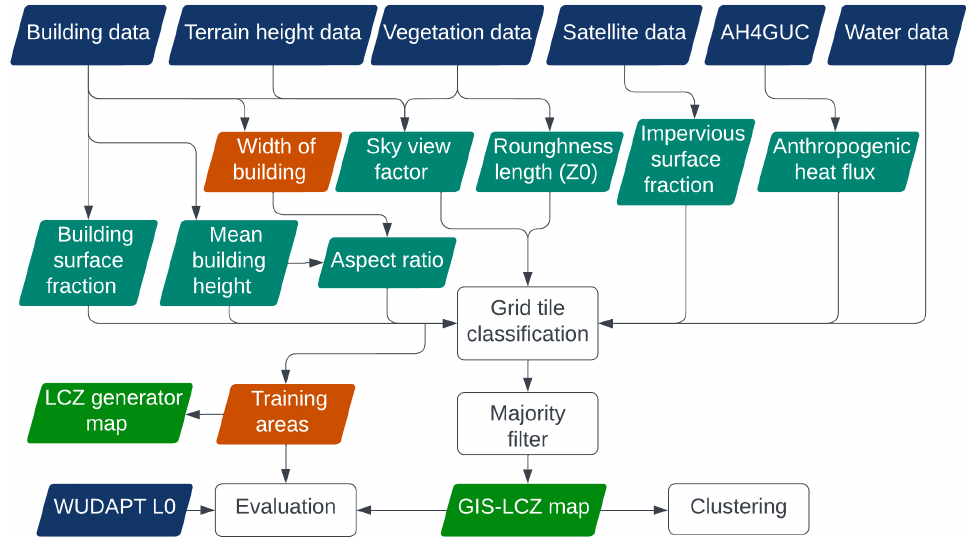
Figure 1. GIS-LCZ mapping method of